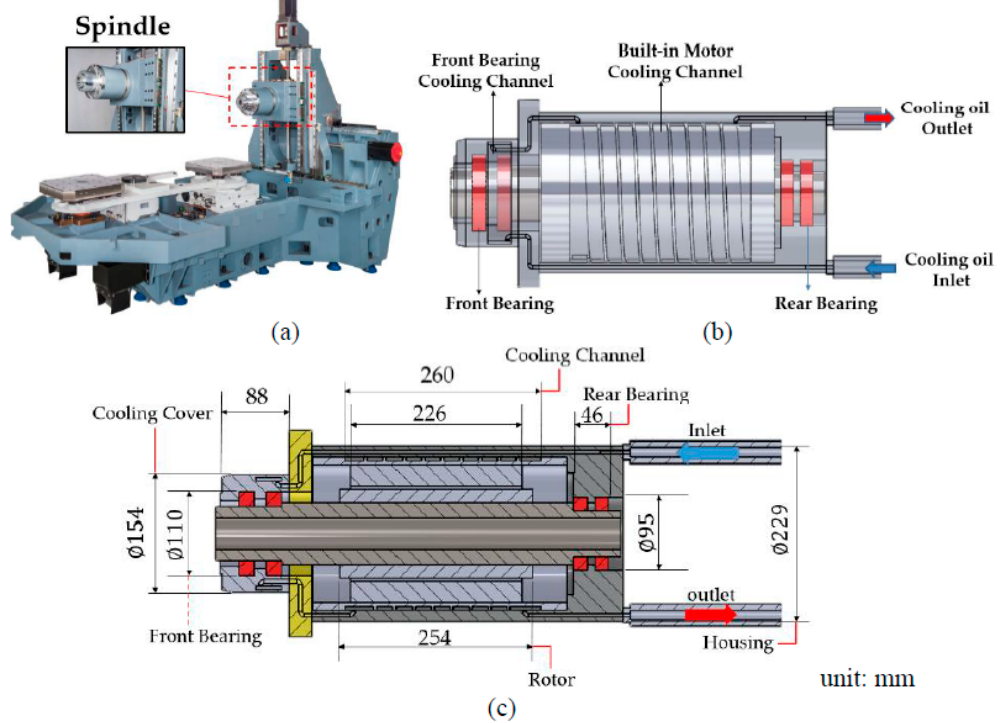
Figure 1. Experimental equipment. ( a ) Horizontal machine tool and built-in spindle; ( b ) Built-in spindle; ( c ) Dimensional drawing.